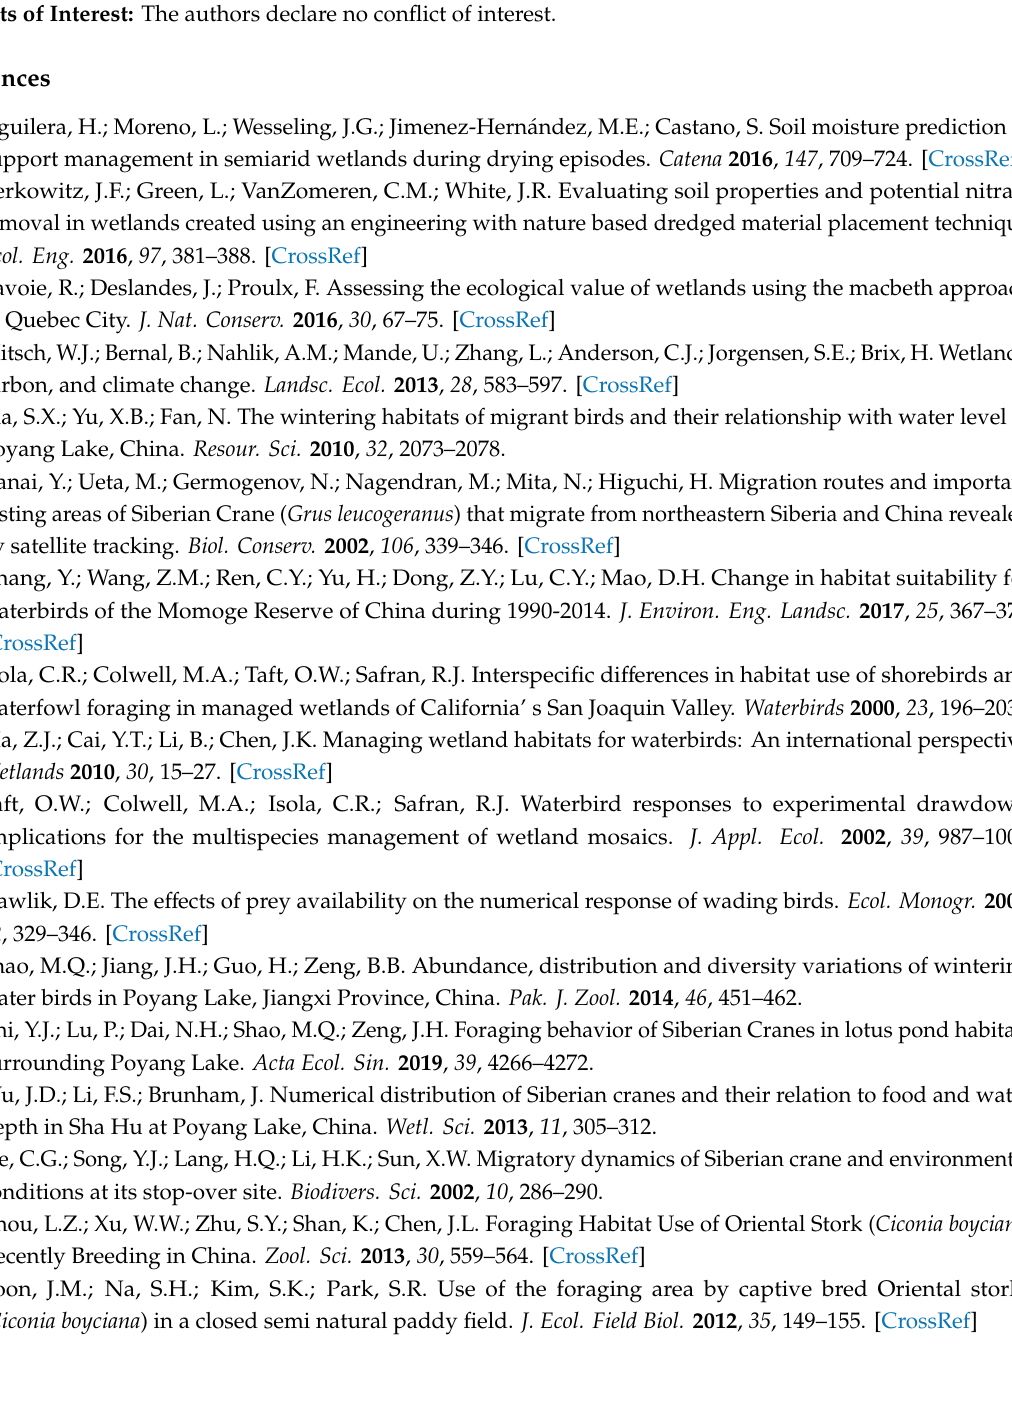
Table S1: Evaluation method of ecosystem service value evaluation index system, Definition, The solution processes of IPTSP